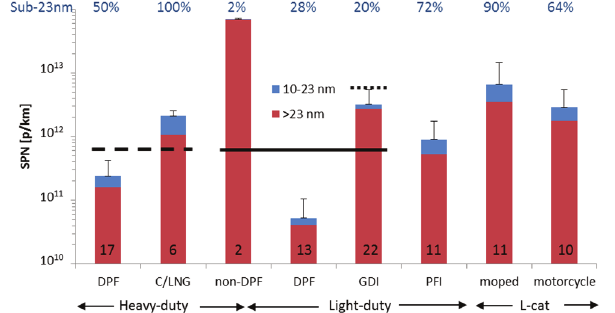
Fig. 5. Overview of emission levels of different current vehicle categories, based on JRC measurements [15, 30, 32, 33]. Error bars show one standard deviation (only positive side) for the number of vehicles shown in each bar. Horizontal lines give the European regulated SPN limits for SPN > 23 nm. Note that for the GDIs of this figure the limit was 6×10 12 p/km (dotted line). The dashed line shows a limit of 6×10 11 p/km. However, the SPN Fig. 4. Upper panel: Counting efficiency in function of monodisperse limit applies only to heavy-duty engines (not vehicles) and is expressed in mobility diameter of two VPRs of PMP systems with Evaporation Tube p/kWh. All tests were conducted at temperatures around (ET) [29] or Catalytic stripper (CS) [30] (examples). Lower panel: Differ- ence of the two systems for various polydisperse size distributions with various Count Median Diameters (CMD)